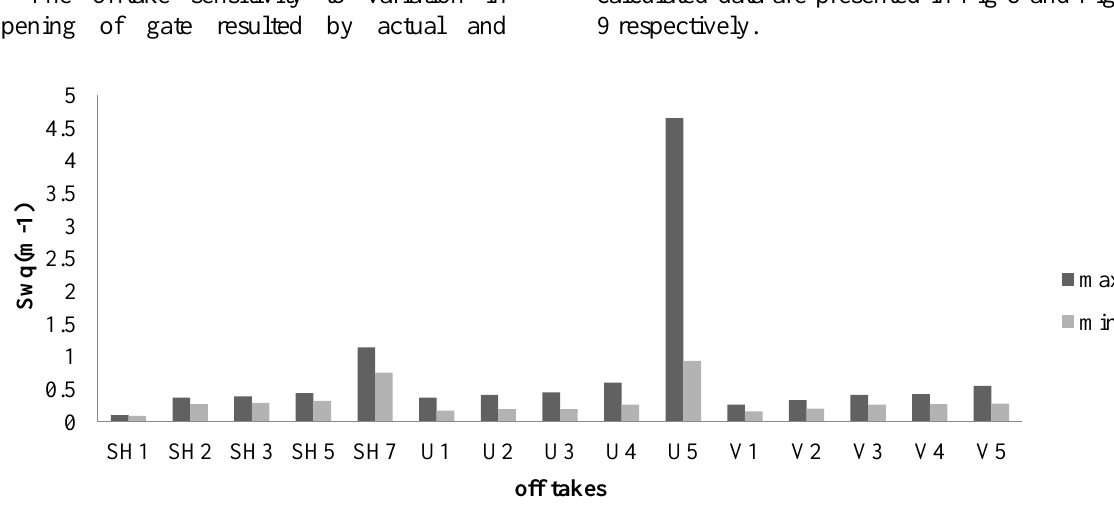
calculated data are presented in Fig 8 and Fig 9 respectively.